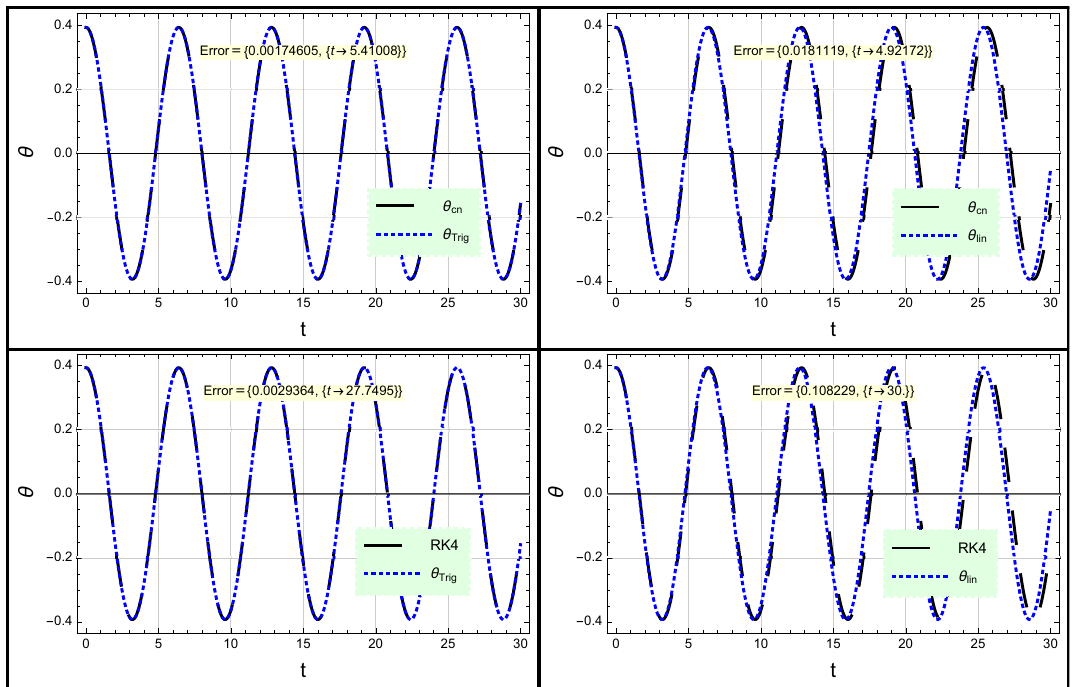
Figure 2. The analytical solution (13) and the approximation (16) to the conserved i.v.p. (1) as well as the exact solution (20) to the i.v.p. (19) (linearized form to the i.v.p. (1)) are compared to the RK4 numerical approximation for